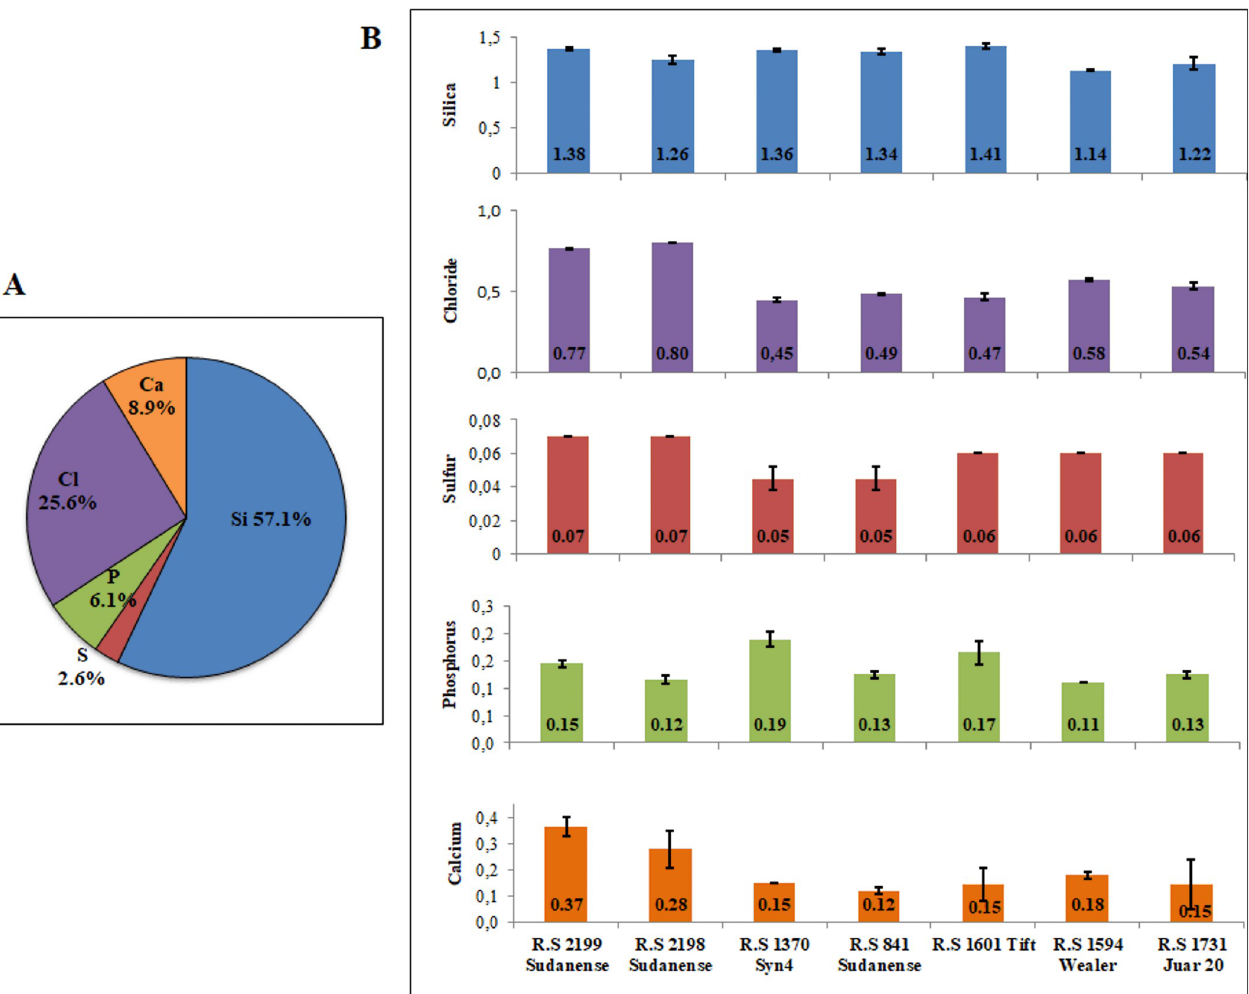
Fig 2. Cell wall elements in stems of sudangrass. (A) Average of elements in cell walls. (B) Cell wall elements by genotype. Vertical bars stand for standard deviation of the means. Note that all the elements analyzed show statistically significant differences across accessions.